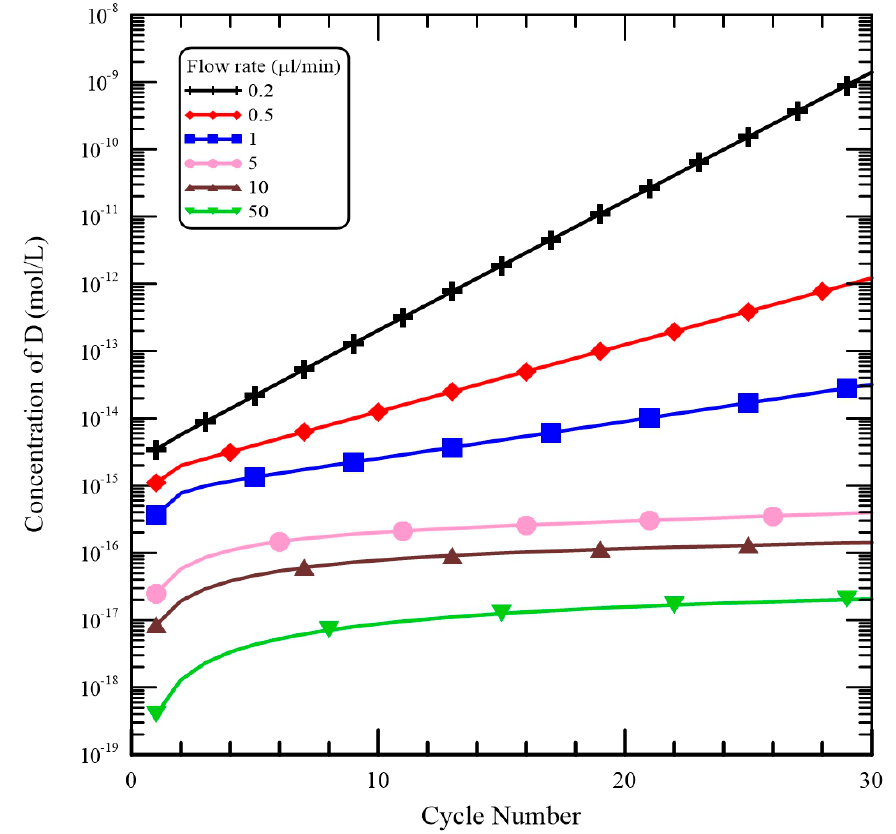
Figure 9. The influence of various flow rates on [ D ].